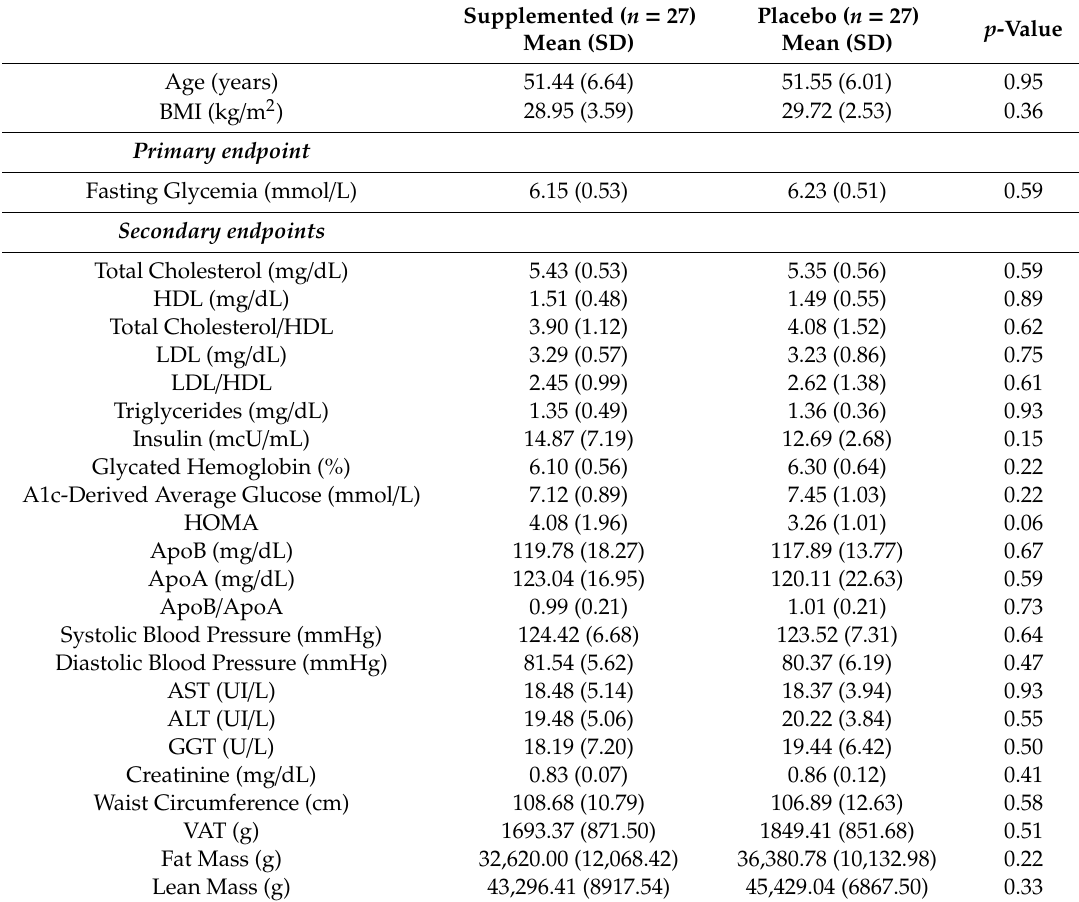
Table 1. Baseline (t 0 ) age, BMI, primary and secondary endpoints mean ± (SD) and p -value for t -test of the di ff erence between the two